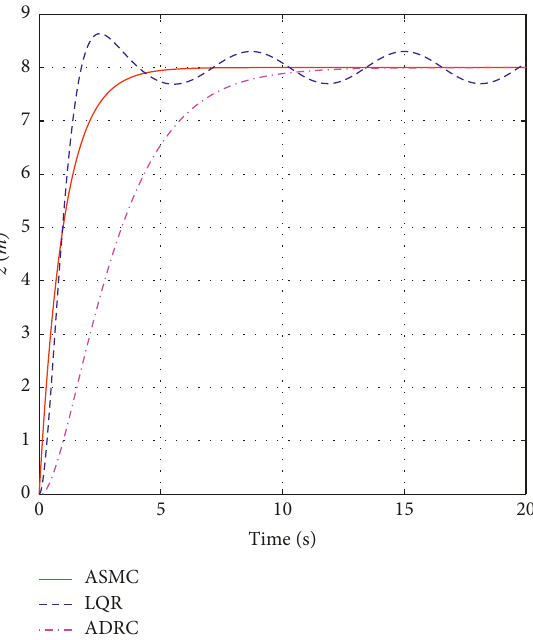
Figure 6: The tracking performance of altitude.